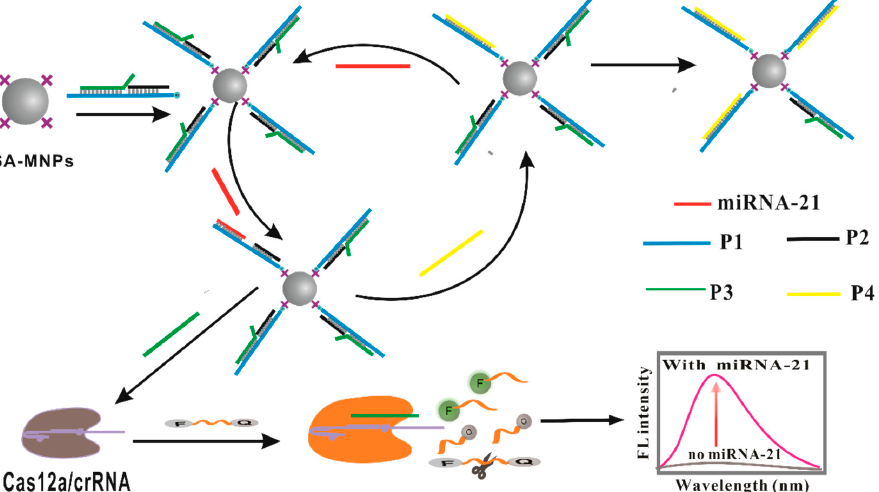
Figure 2. Schematic illustration of fluorescent biosensor for ultrasensitive fluorescence determination of exosomal miR-21 by CRISPR/Cas12a coupling with MNPs and CSDR.